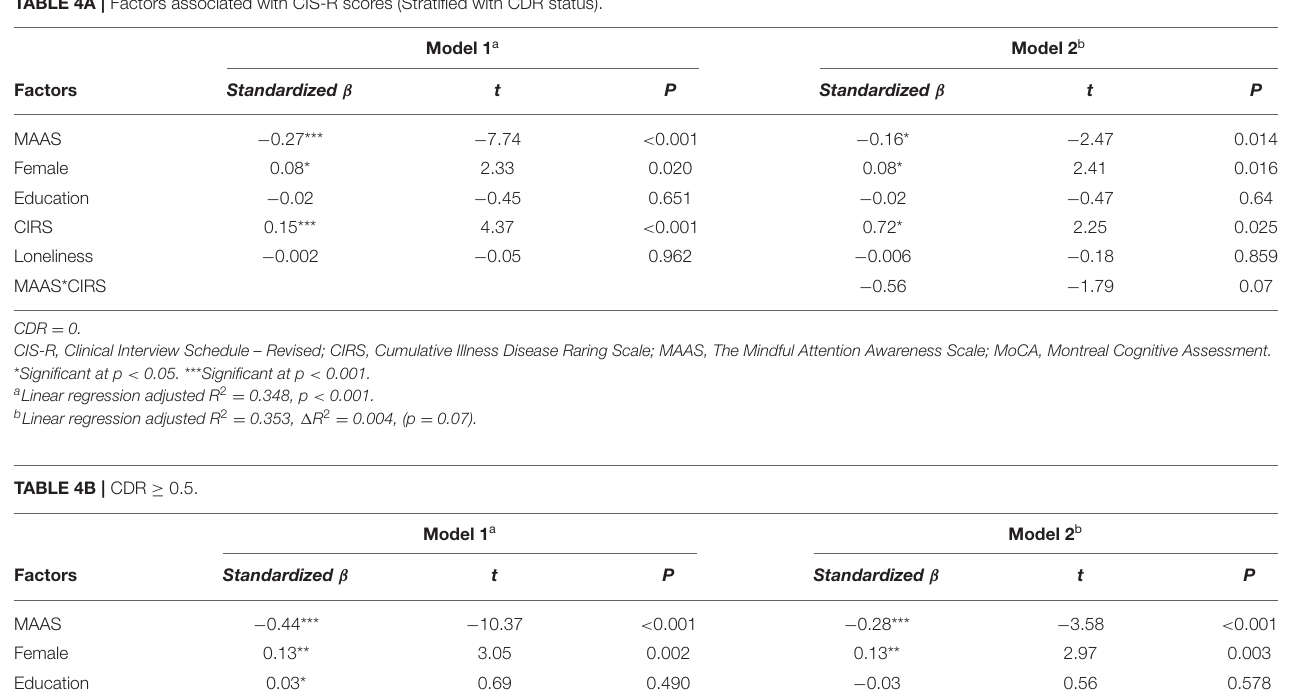
TABLE 4A | Factors associated with CIS-R scores (Stratified with CDR status).